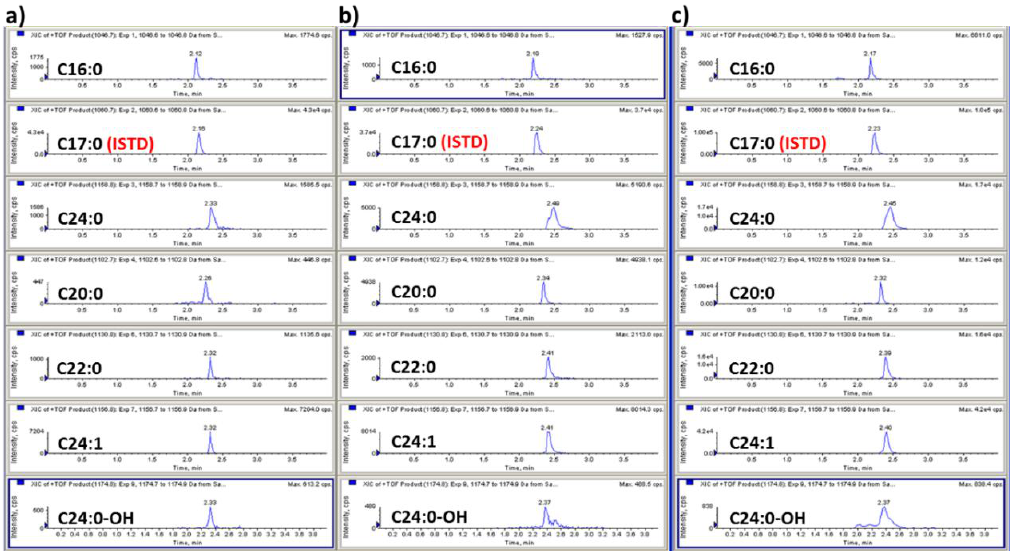
Figure 7. LC-MS chromatograms of GB3 in ( a ) plasma; ( b ) heart; and ( c ) spleen from the Fabry disease model mouse.